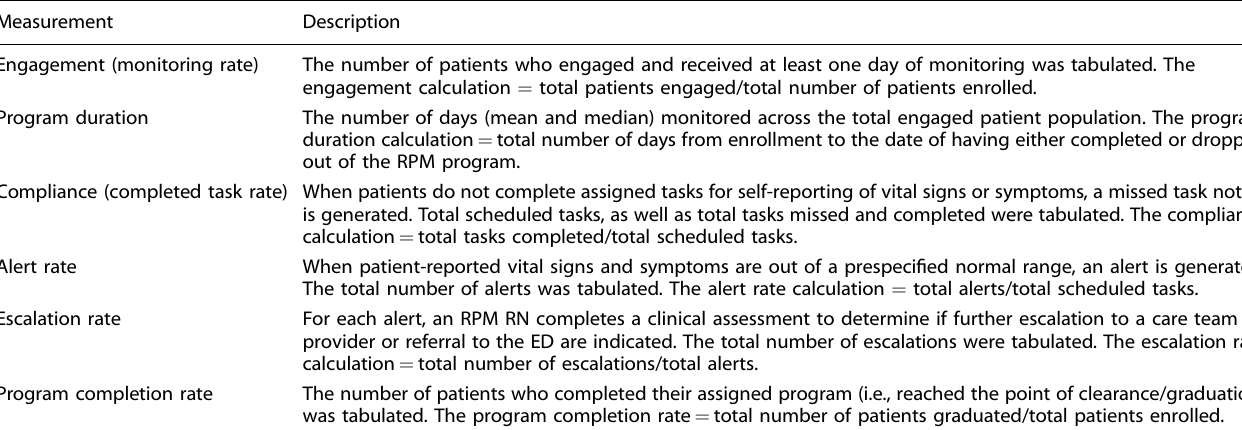
Table 4. De fi nitions of endpoints for COVID-19 RPM program engagement and digital exchanges. Measurement Description Engagement (monitoring